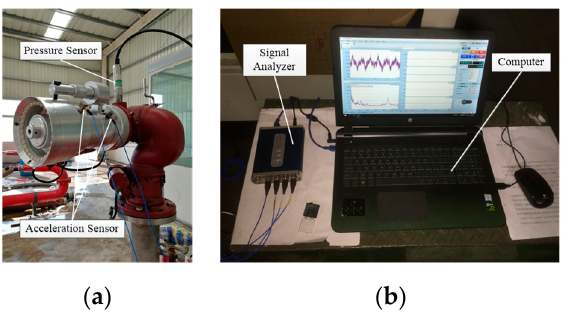
Figure 16. Platform for dynamic experiment of the fire-fighting jet system with the adaptive gun head. ( a ) Prototype of gun head. ( b ) Experimental equipment.